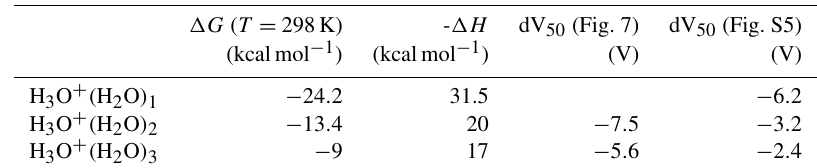
Table 4. Gibbs free energies, binding energies (BE(H 3 O + ( H 2 O ) 1 − 3 ) = - (cid:49)H ) and corresponding dV 50 for H 3 O + ( H 2 O ) 1 − 3 clusters (Meot- Ner, 1984) determined for a dV scan shown in Figs. 7 and S5.